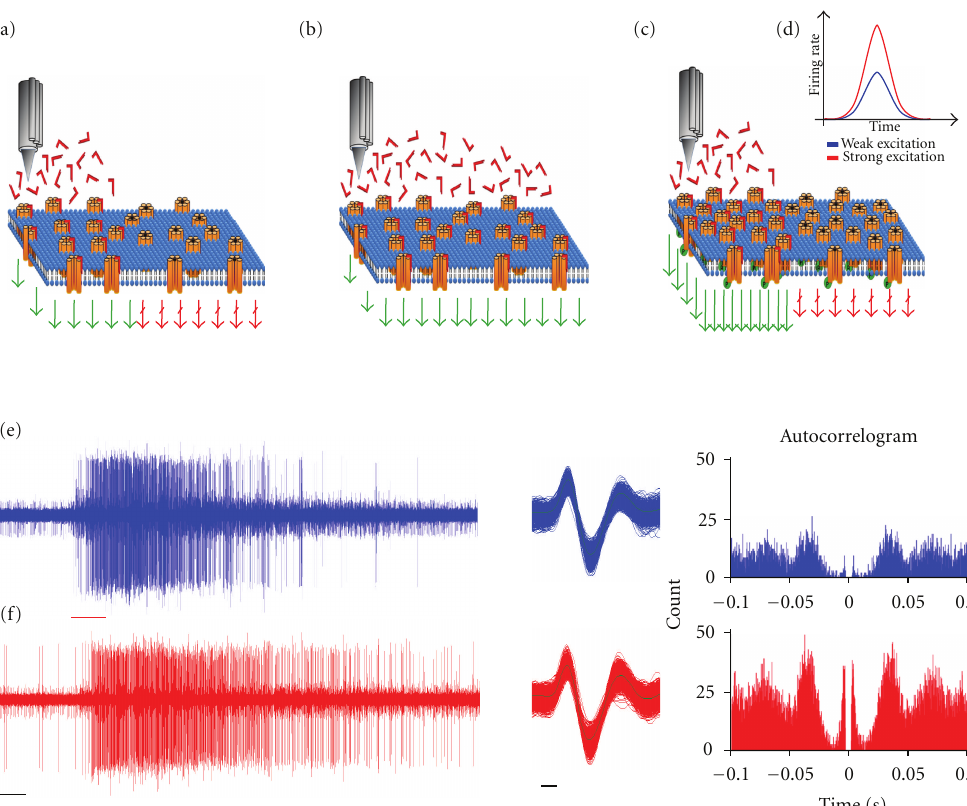
Figure 1: Schematic outline of the experiment. CA1 cells were excited by a small (a) or large (b) dose of excitatory compound (AMPA or NMDA). In a second set of experiments, AMPA receptor phosphorylation (GluA1 subunit), which might lead to increased AMPA receptor surface expression and subsequent rise in AMPA-evoked firing rate, was induced by an intraperitoneal tianeptine injection (c). Strong excitations triggered larger firing rates than weak excitations (d). Representative spike trains, superimposed spikes, and autocorrelograms of the same unit before (e) and 15 min after tianeptine injection (f). Red line marks the ejection event. Scale bars are 50 μ V and 1 sec and